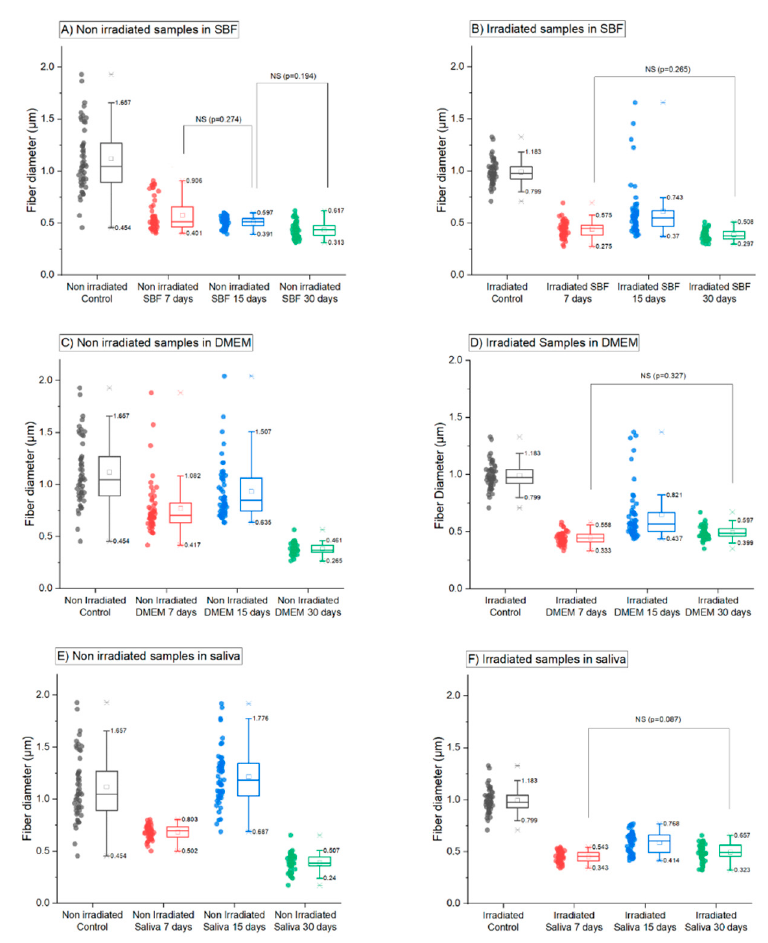
Figure 4. Distribution of fibers diameter for non-irradiated (left) and gamma irradiated PLGA fibers (right) after in vitro degradation during 30 days of immersion in SBF ( A , B ), DMEM ( C , D ) and saliva ( E , F ) (the mean value of the diameters is represented by a square and median value by a horizontal line in the box). NS indicates that the difference of the means is not significant at the 0.05 level (probability specified in bracket and calculated via a Tukey test). If nothing is specified, the difference of the means is significant at the 0.05 level for a pair of samples.